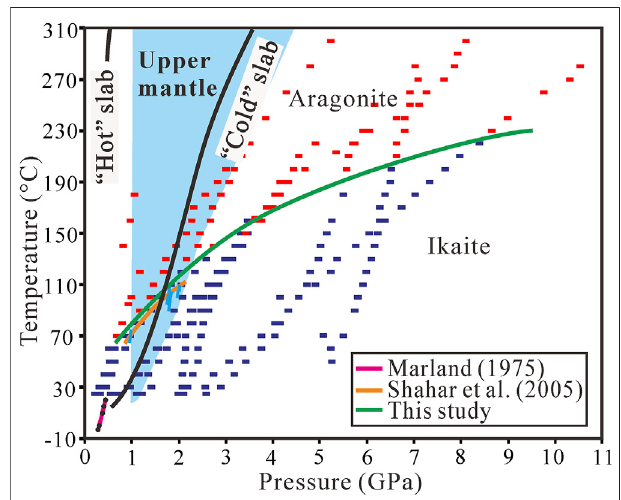
FIGURE 9 | The phase diagram of the transition of ikaite to aragonite extended to 9 GPa and 220 ° C.